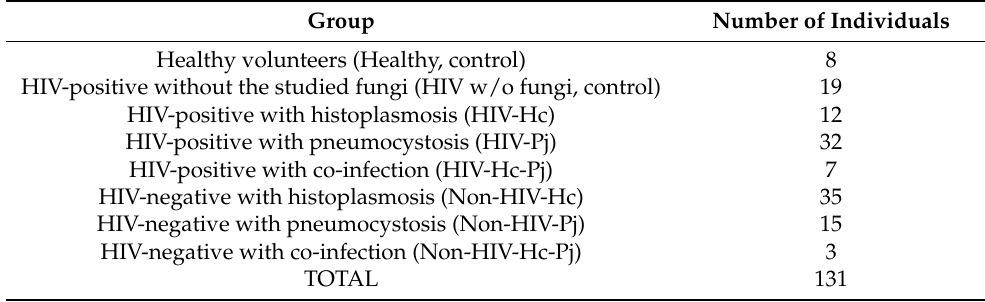
Table 1. Studied groups of individuals. Abbreviations in parenthesis are the same in all figures. Group Number of Individuals Healthy volunteers (Healthy, control) 8 HIV-positive without the studied fungi (HIV w/o fungi, control) 19 HIV-positive with histoplasmosis (HIV-Hc) 12 HIV-positive with pneumocystosis (HIV-Pj) 32 HIV-positive with co-infection (HIV-Hc-Pj) 7 HIV-negative with histoplasmosis (Non-HIV-Hc) 35 HIV-negative with pneumocystosis (Non-HIV-Pj) 15 HIV-negative with co-infection (Non-HIV-Hc-Pj) 3 TOTAL